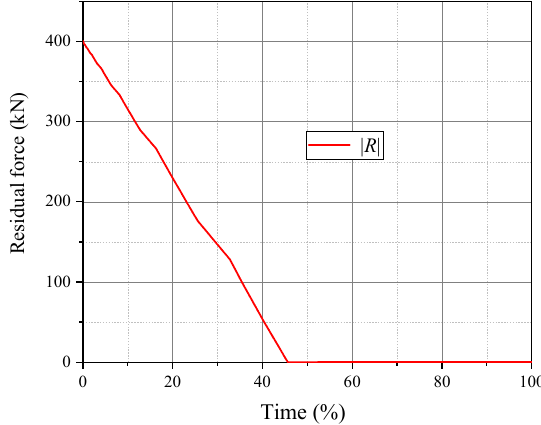
Figure 14. Residual force | R | changing curve.